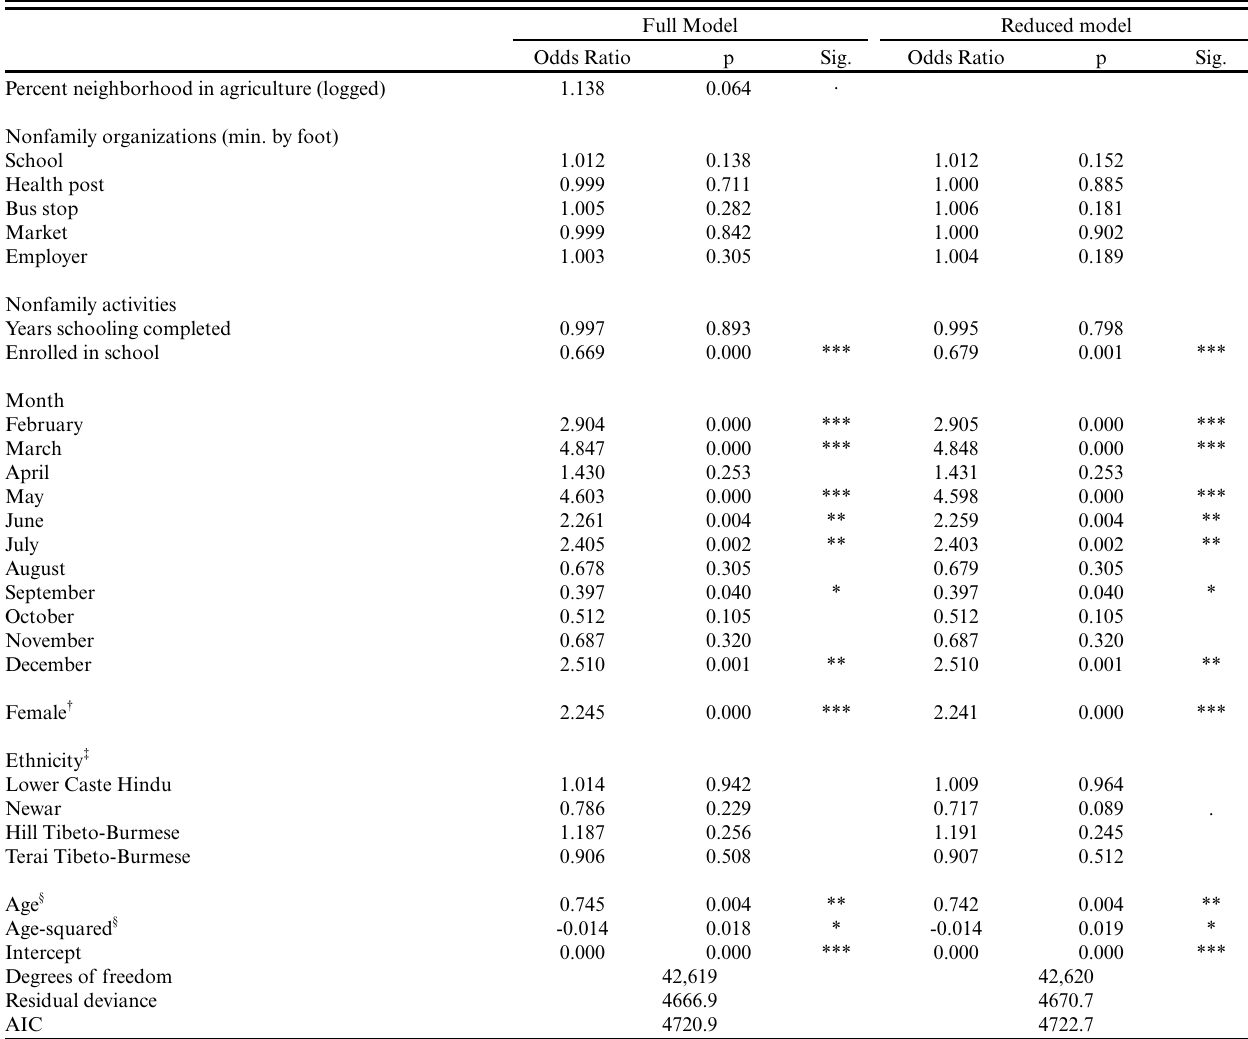
Table 3 . Marriage models (following the work of Yabiku 2006 a ). Odds-ratios are from a discrete-time event history analysis predicting monthly hazard of first marriage. Listed in parentheses are the z-scores for each